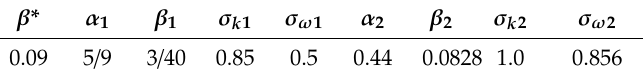
Table 1. Parameters of SST k - ω turbulent